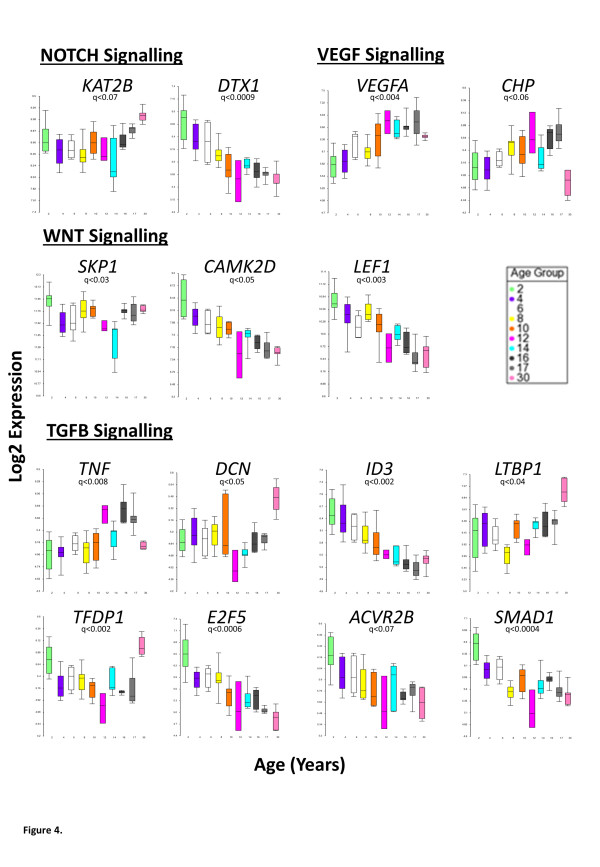
Significant development-related changes in the NOTCH, VEGF, TGFB and WNT pathways as identified by the analysis of the essential properties of gene networks. Exemplar genes from each of these pathways are presented (ANOVA, false discovery rate (FDR) corrected p-value, q < 0.1). Box and whisker plot (whiskers = top and bottom 10%) of gene expression as Log2 normalised values (y-axis). The x-axis is age-banded in years (upper limit of age group bin).